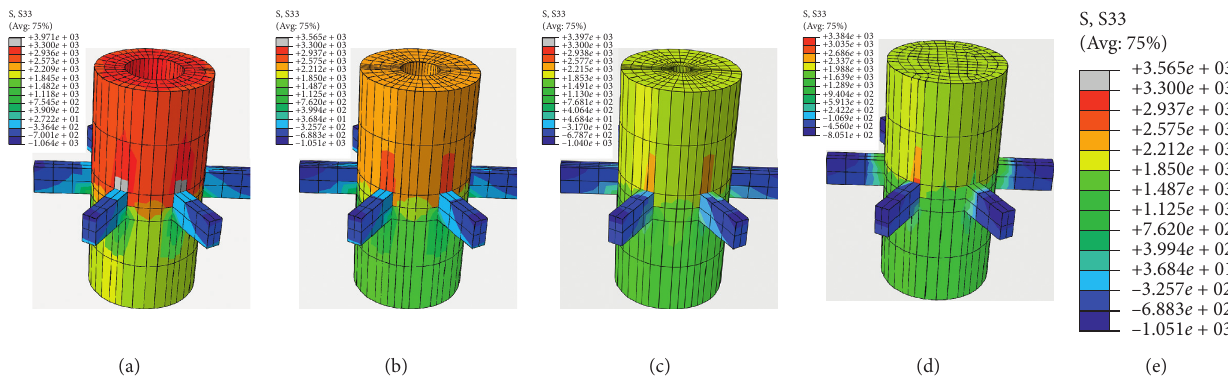
Figure 16: Axial stress distribution of piles of 1.2m in diameter with different wall thickness. (a) 0.3m. (b) 0.4 m. (c) 0.5 m. (d) Solid pile. (e) The legend. The unit of the legend in Figures 16(e), 17(e), and 18(e) is